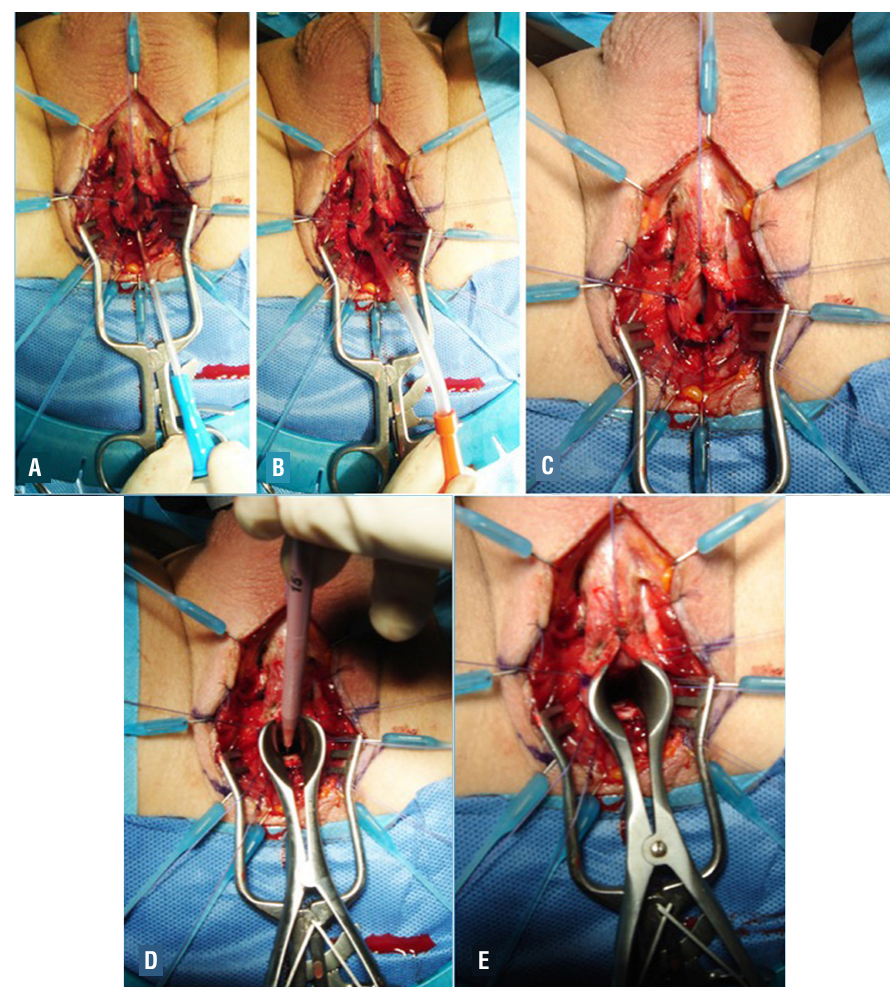
Figure 6 – A-E) Progressive urethral dilation over catheter until